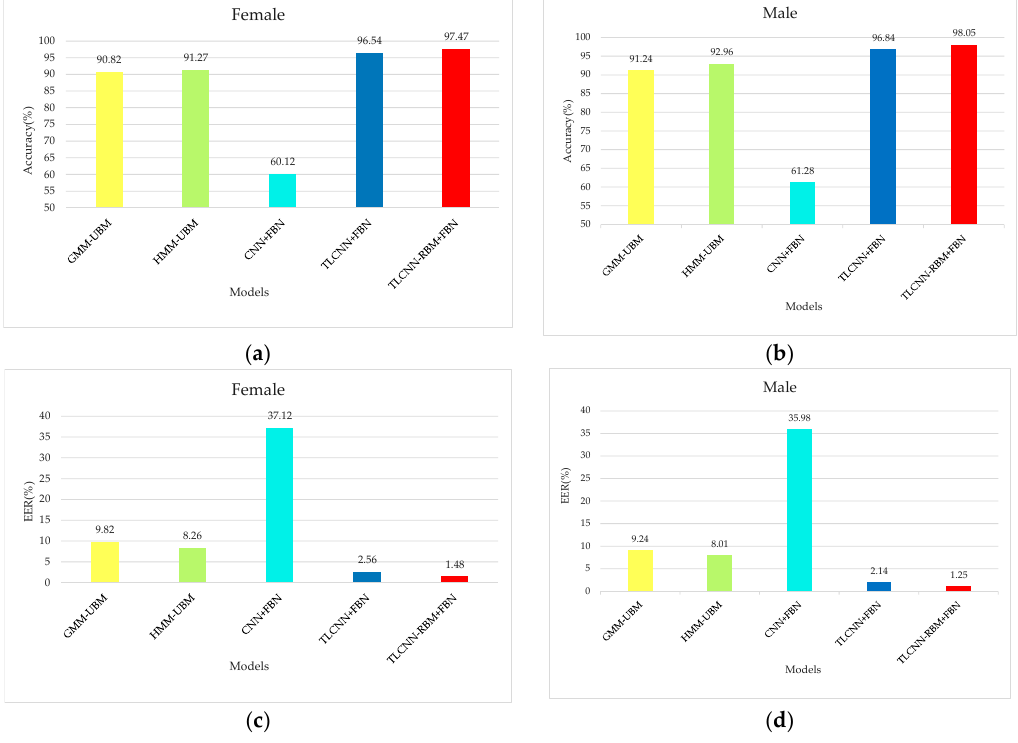
Figure 11. Comparison of the performance for five models. ( a ) Comparison of accuracy for five models based on female, ( b ) comparison of accuracy for five models based on male, ( c ) comparison of EER for five models based on female, and ( d ) comparison of EER for five models based on male.